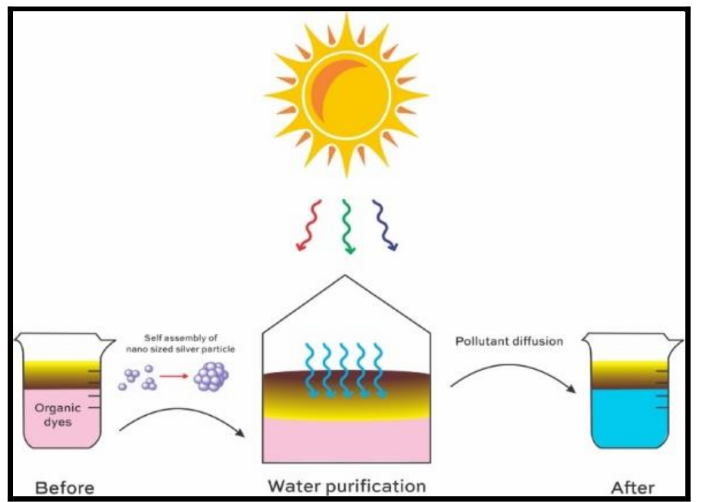
Figure 8. Sensing the toxic organic dyes by asymmetric nano-sized silver particle based plas- monic